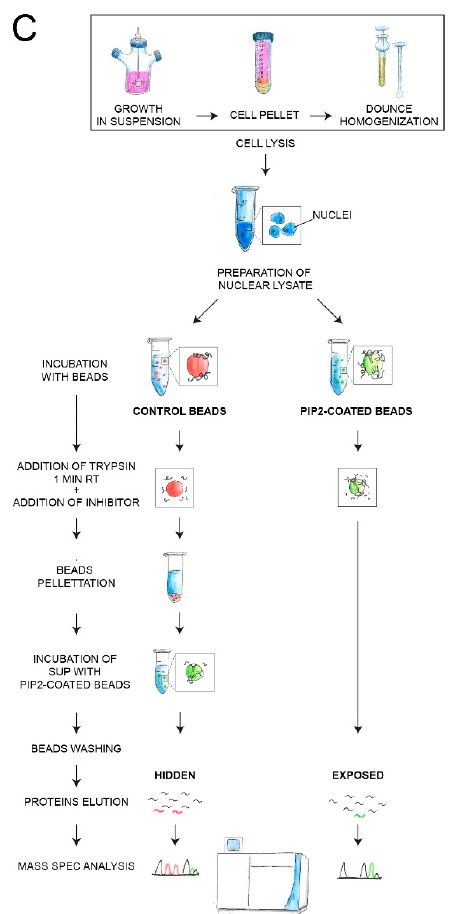
Figure 1. ( A ) Comparison of the trypsin cleavage block efficacy between inhibitor mix and heat inactivation. Bovine serum albumin (BSA) and its cleavage products were Coomassie Brilliant Blue-stained in polyacrylamide gel. First lane (from left) contains only BSA. In second lane, the inhibitors were added to the sample prior to trypsin digestion. Third lane contains a reaction where inhibitors were added after 1 min of trypsin incubation. In fourth lane, the sample was boiled after 1 min of trypsin incubation. All reactions were incubated at 4 ◦ C for additional 1 h to ensure the stability of the trypsin inactivation. ( B ) Western blot (WB) analysis showing the purity of limited proteolysis (LiP) protein lysate starting material. NL—Nuclear lysate, CL—cytoplasmic lysate. WB shows immunodetected nuclear marker lamin A and the cytoplasmic marker GAPDH. ( C ) Scheme of the Phosphoinositide Phosphates based Limited Proteolysis quantitative Mass Spectrometry (PIPsLiP- qMS) experimental workflow. HeLa cells were grown in suspension into high densities followed by centrifugation and Dounce homogenization. The separation of nuclei from cytoplasm was done by centrifugation. Isolated nuclei were sonicated and lysates were prepared. Nuclear lysates were used as starting material in subsequent steps. Phosphatidylinositol 4,5-bisphosphate (PIP2)-coated beads or control beads were added into the nuclear lysate. The control beads served as free surface which might bind proteins non-specifically and thus protect them from trypsin cleavage. In the next step, trypsin was added into both reactions and then it was inhibited after 1 min of incubation at RT. Inactivation was done under non-denaturing conditions (inhibitors), therefore, PIP2-binding capacities of proteins remain persistent. Control beads were collected by centrifugation and discarded from the control sample. The supernatant was transferred into a clean tube and fresh PIP2-covered beads were added and incubated at 4 ◦ C for 1 h. Capacity of proteins to bind PIP2 in this step should be diminished, since the binding sites were not protected by the ligand during LiP. Thus, lower amounts of these proteins will co-precipitate together with PIP2-covered beads. Washed PIP2-beads from both samples were collected; proteins were eluted and subjected to sample preparation for quantitative mass spectrometry